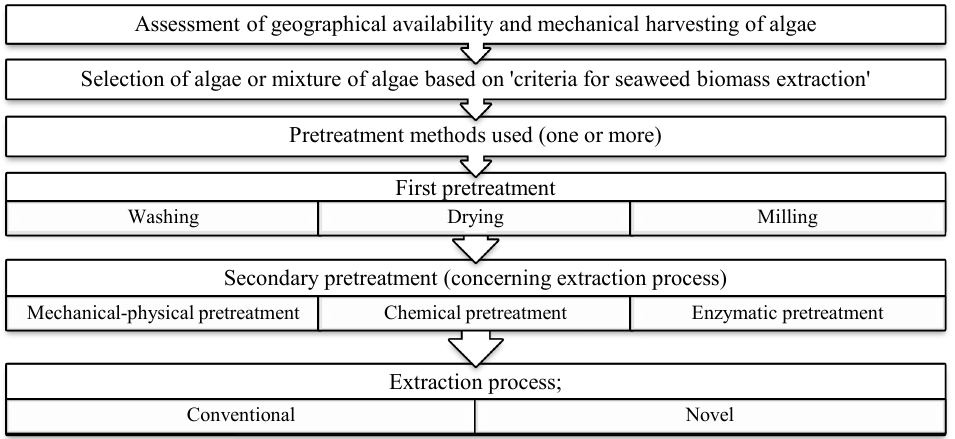
Fig. 1 . Scheme of seaweed handling before extraction